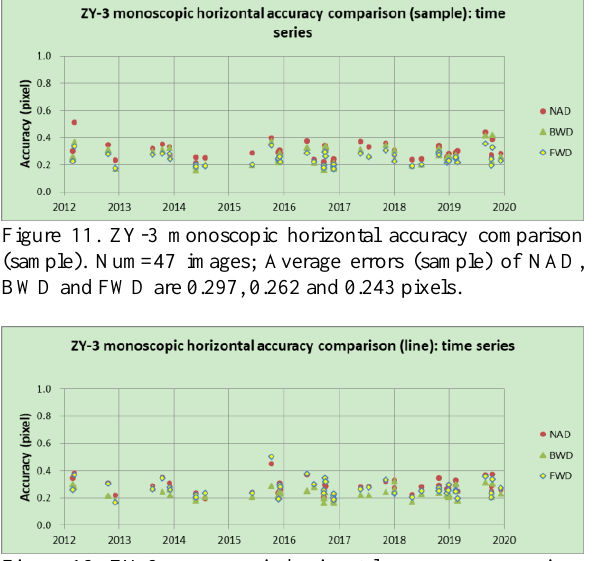
Figure 12 . ZY-3 monoscopic horizontal accuracy comparison (line). Num=47 images; Average errors (line) of NAD, BWD and FWD are 0.283, 0.236 and 0.267 pixels.